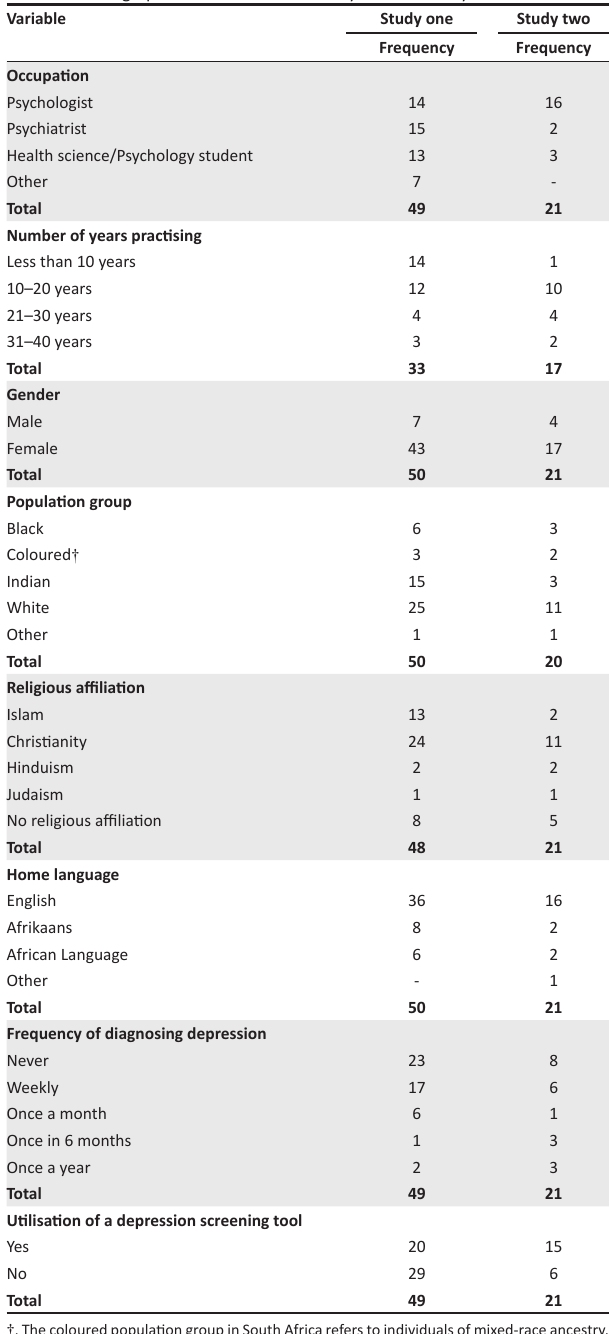
TABLE 2: Demographic characteristics of study one and study two.